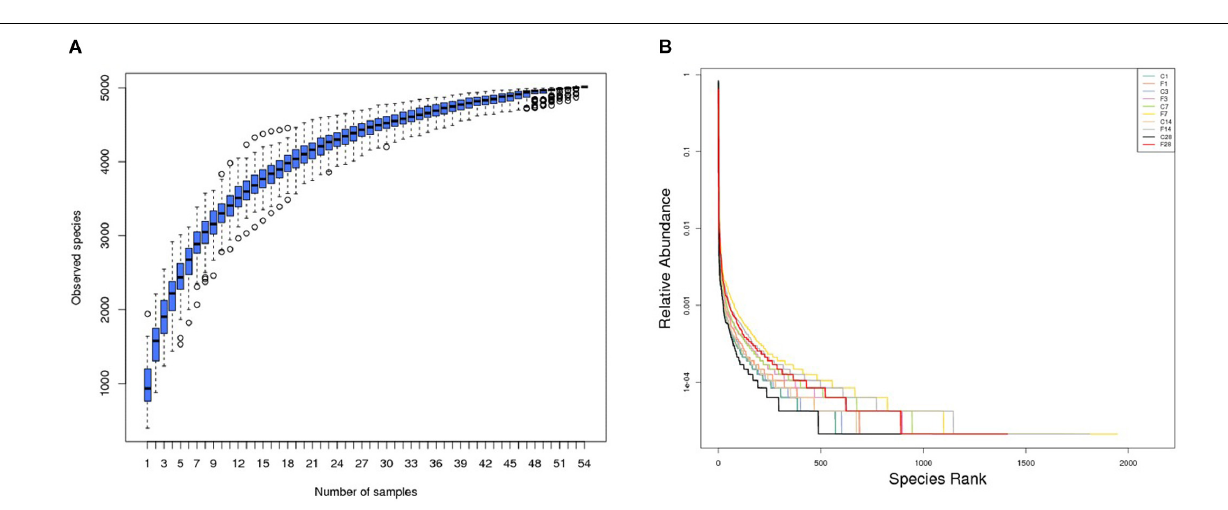
FIGURE 2 | Altered LRT microbiome in mice ( n = 54) inoculated with saline or H1N1 influenza virus in terms of (A) species richness and (B) relative abundance (C, the group treated with saline; F, the group treated with influenza virus; the number followed C/F represented the day post